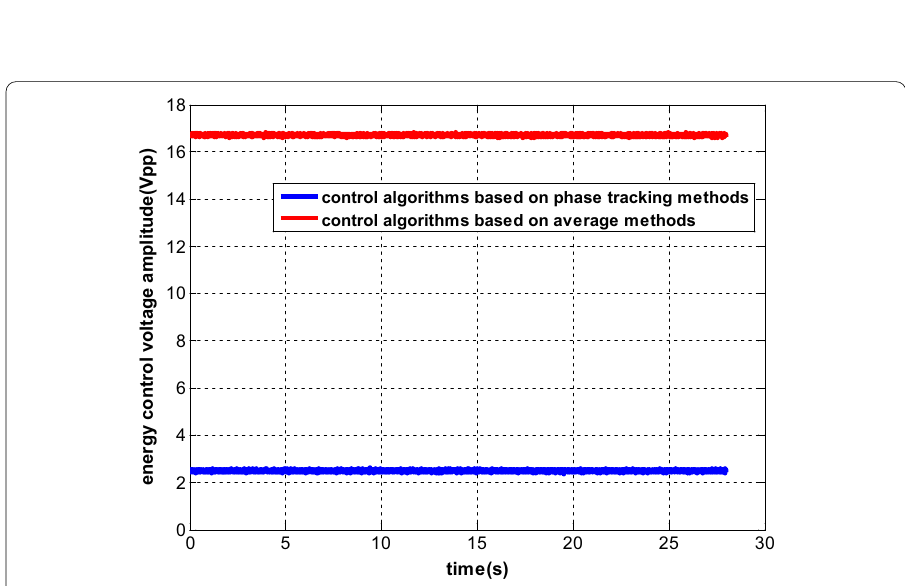
Fig. 6 The energy control loop voltage in two